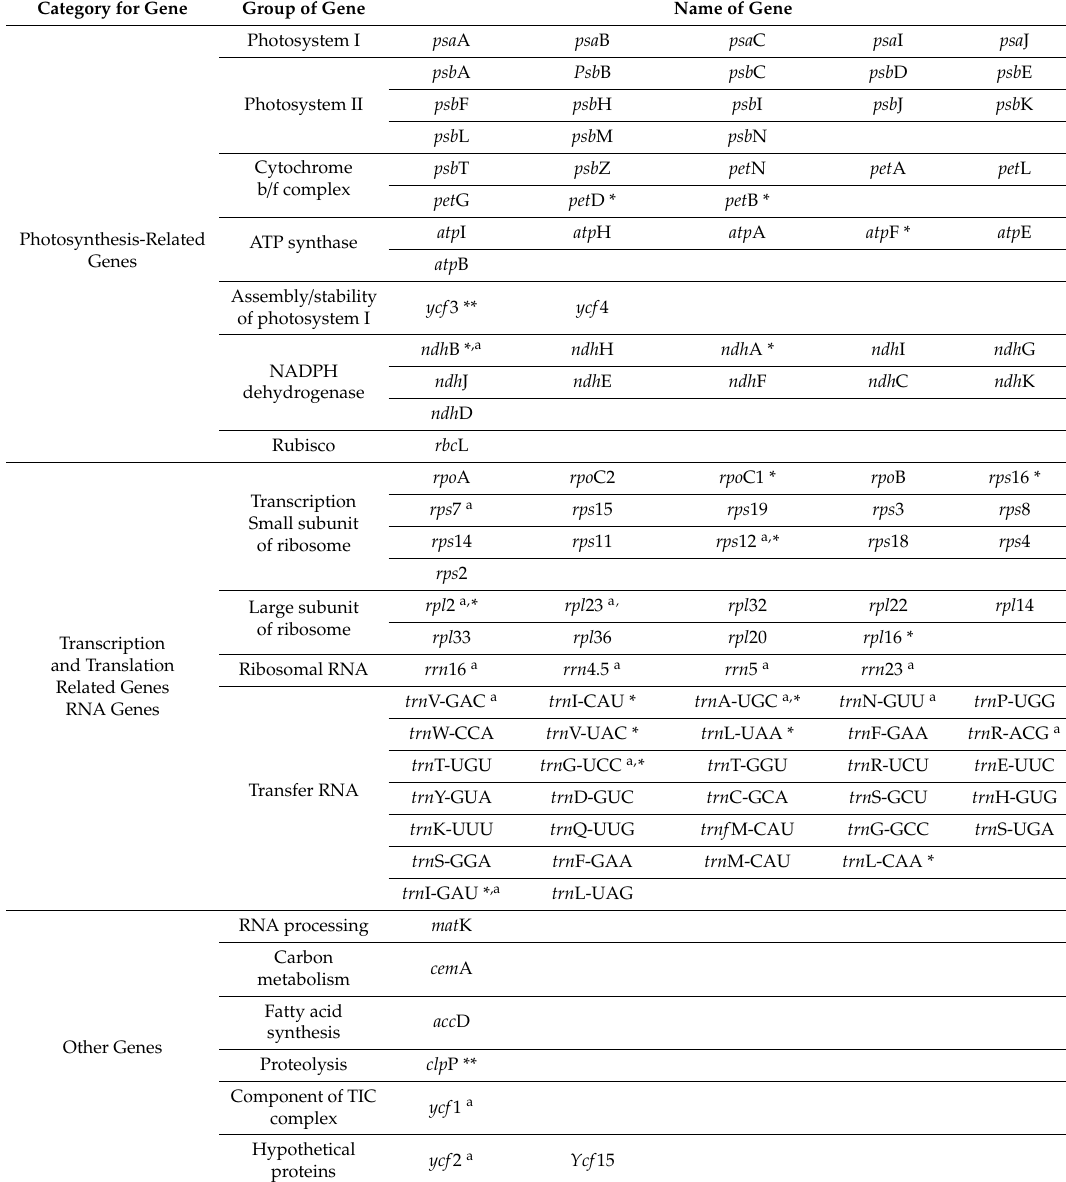
Table 2. Genes and their functional categories in Withania chloroplast